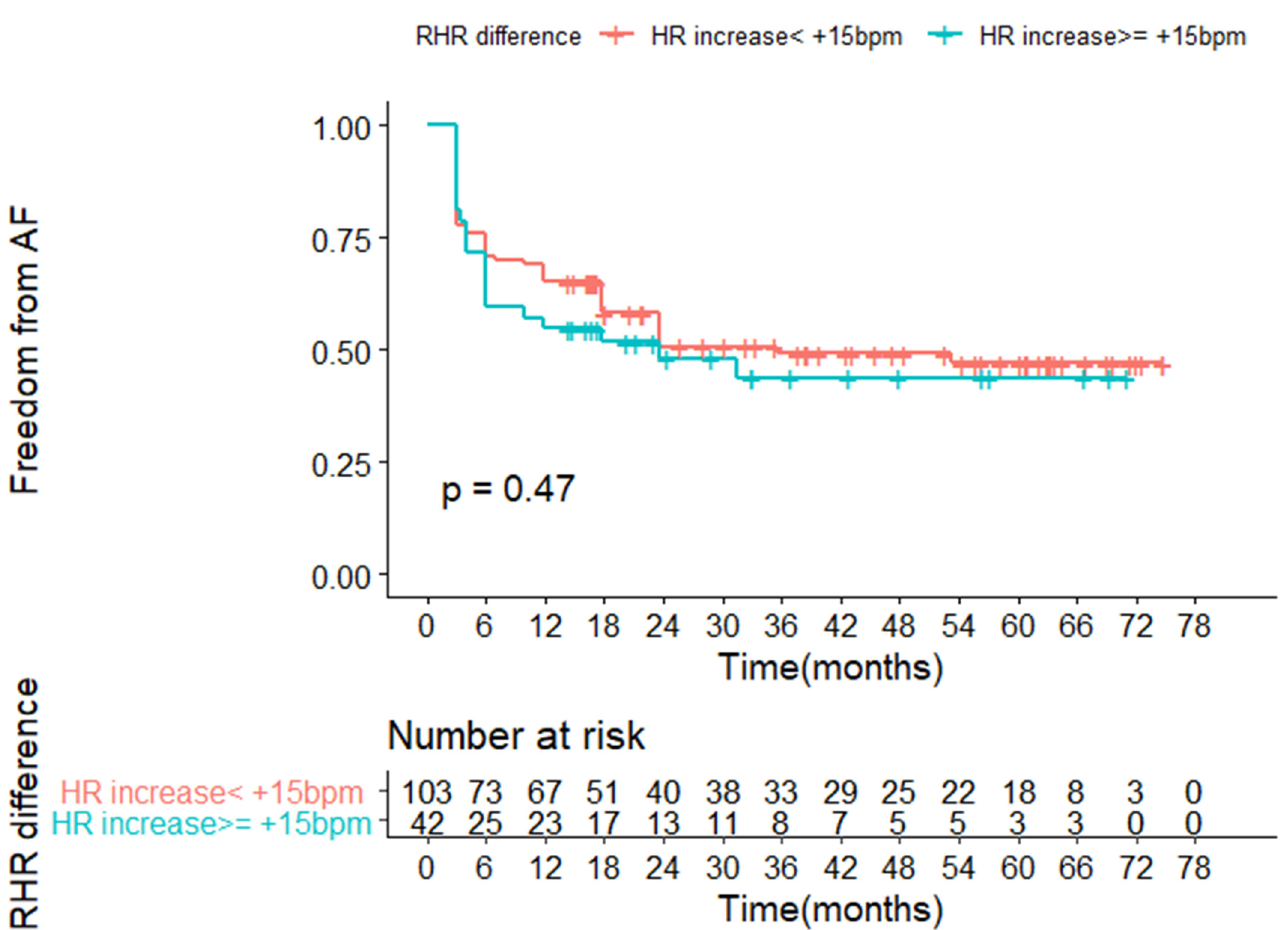
Table 3. Multivariable analysis of predictors of AF recurrence. Variable